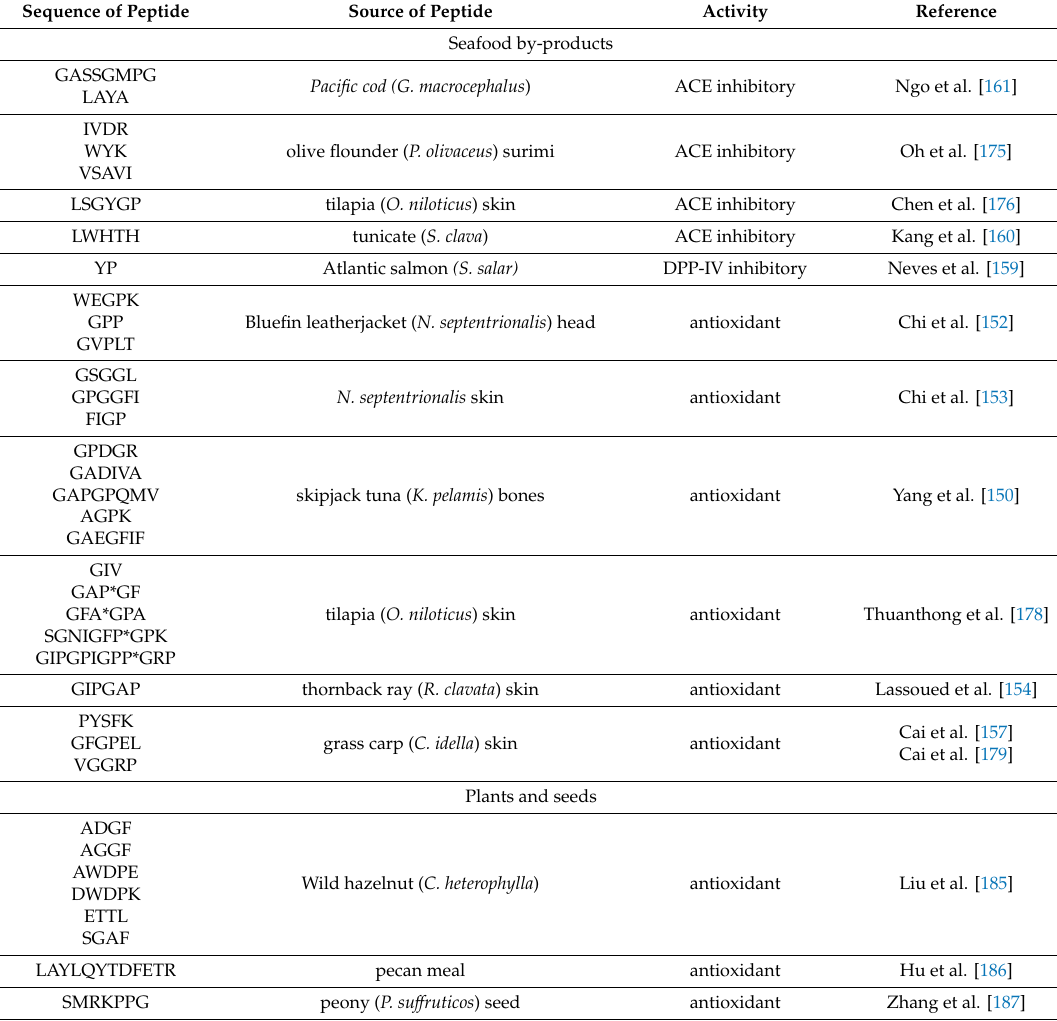
Table 5. Bioactive peptides obtained from seafood